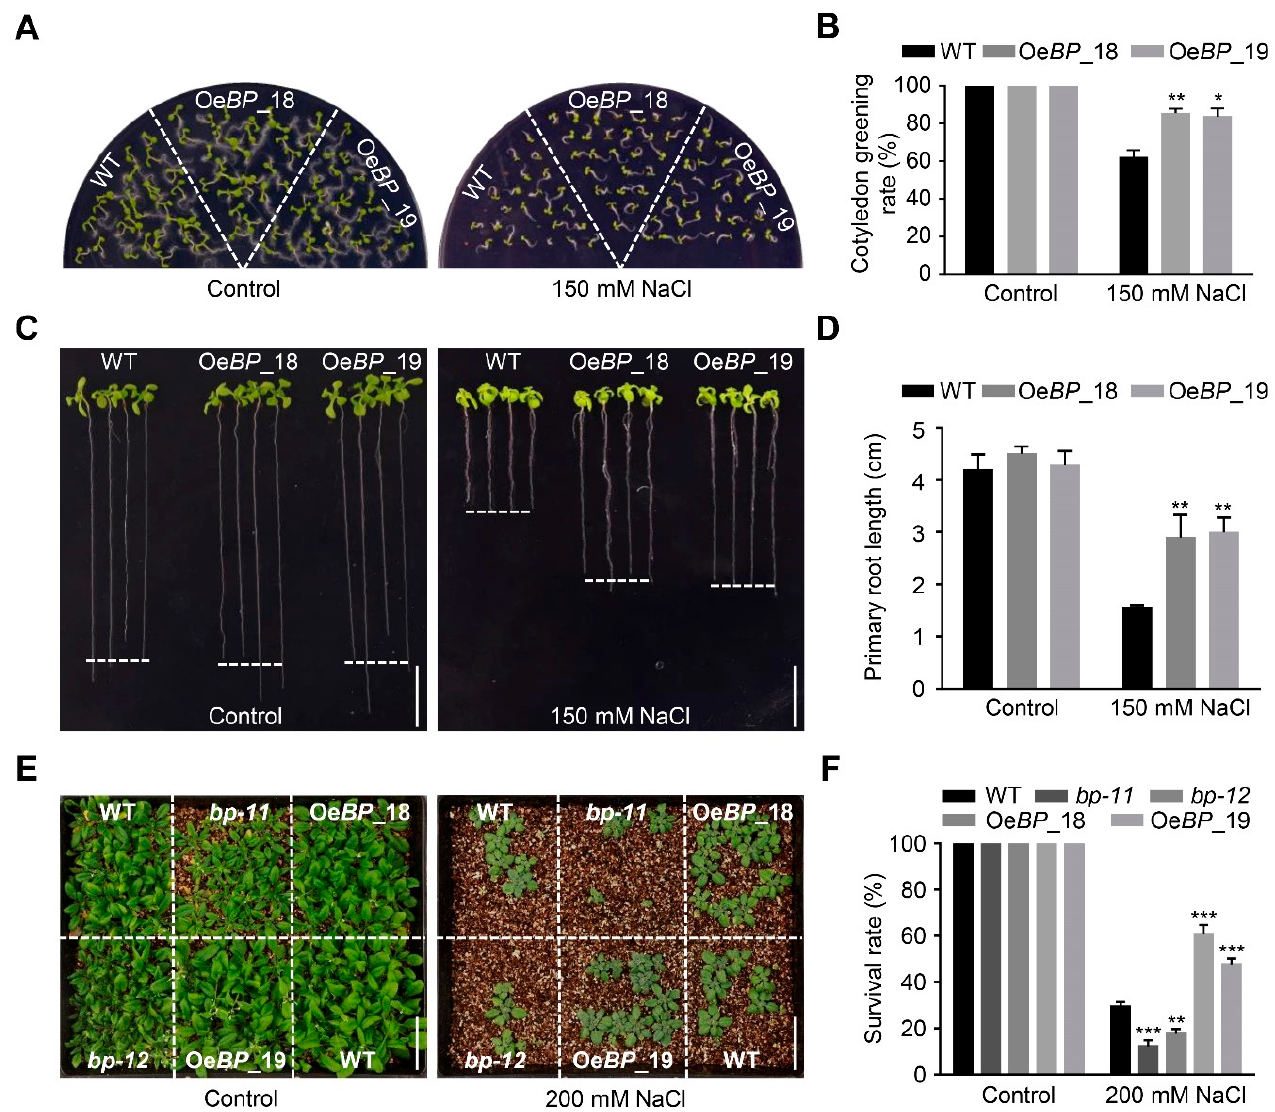
Figure 3. Overexpression of BP enhances salt-stress tolerance. ( A ) Seven-day-old WT and BP -overexpression seedlings grown on 1/2 MS medium with or without 150 mM NaCl. ( B ) Cotyledon-greening rate of the seedlings in ( A ). ( C ) WT and BP -overexpression lines on 1/2 MS medium with or without 150 mM NaCl. Three-day-old seedlings of WT and BP -overexpression lines grown on 1/2 MS medium were transferred to 1/2 MS medium with or without 150 mM NaCl for another 10 d. Scale bar = 1 cm. ( D ) Primary-root length of the seedlings in ( C ). ( E ) Four-week-old WT, mutants and overexpression lines grown in vermiculite with or without 200 mM NaCl treatment. Scale bar = 5 cm. ( F ) Survival rate of the seedlings in ( E ). The bars indicate means ± sd of three independent replicates. * p < 0.05, ** p < 0.01, *** p < 0.001 (Student’s t test).